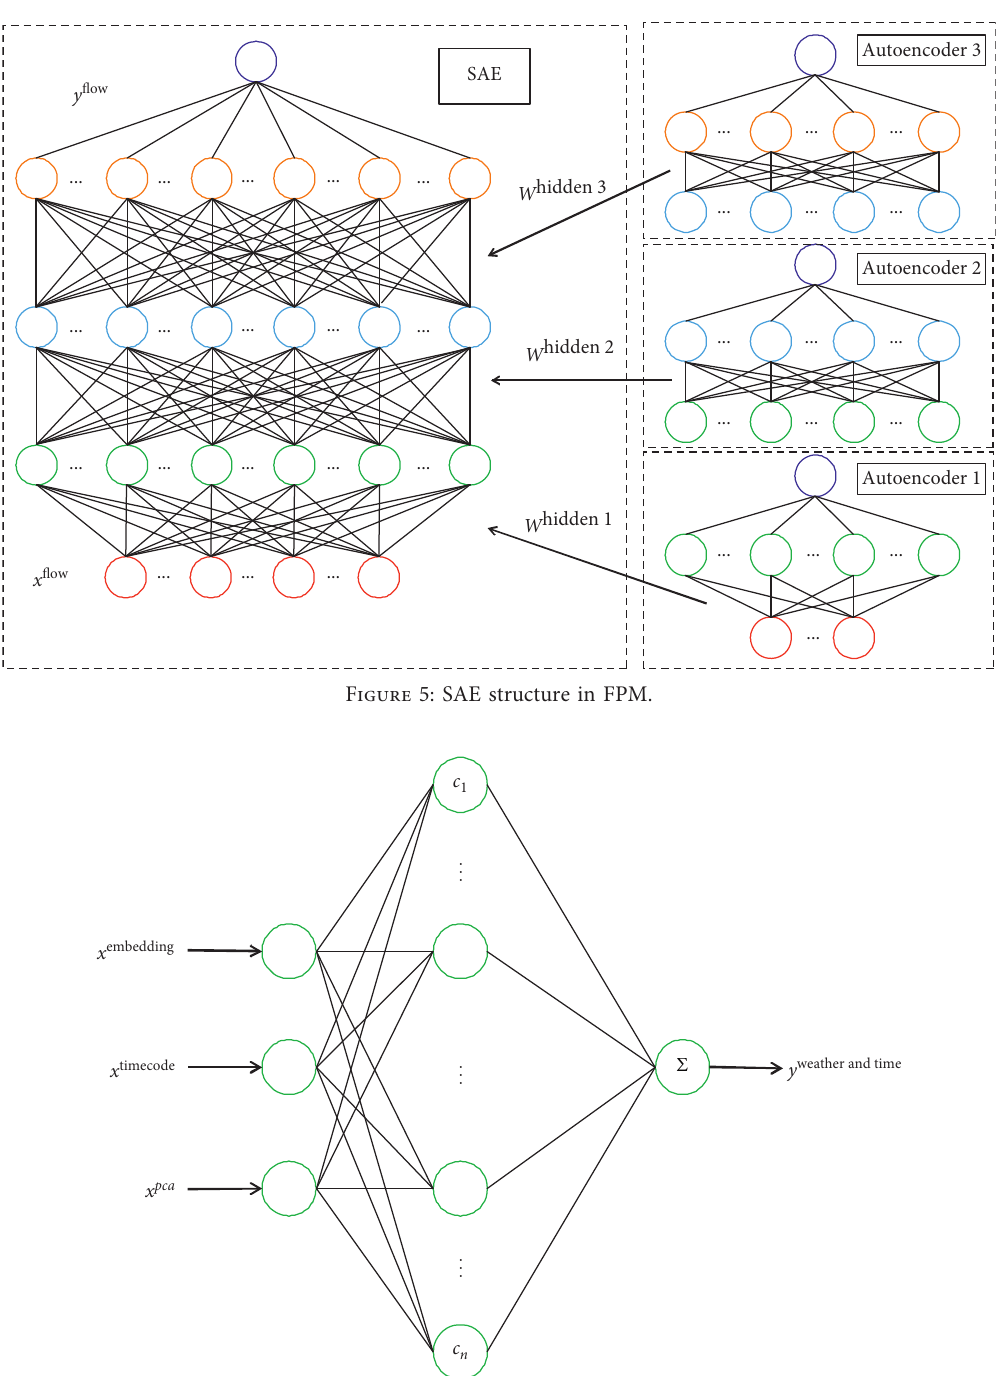
Figure 6: The structure of RBF in WPM.